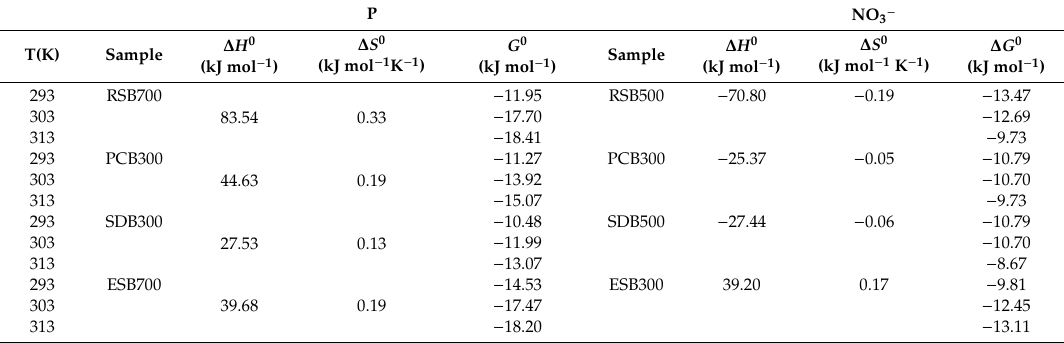
Table 6. Thermodynamic parameters for P and NO 3 −